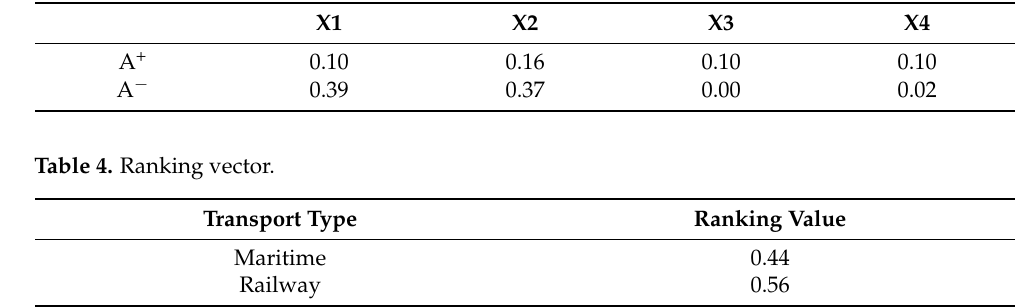
Table 3. The best alternative A + and the worst alternative A − .